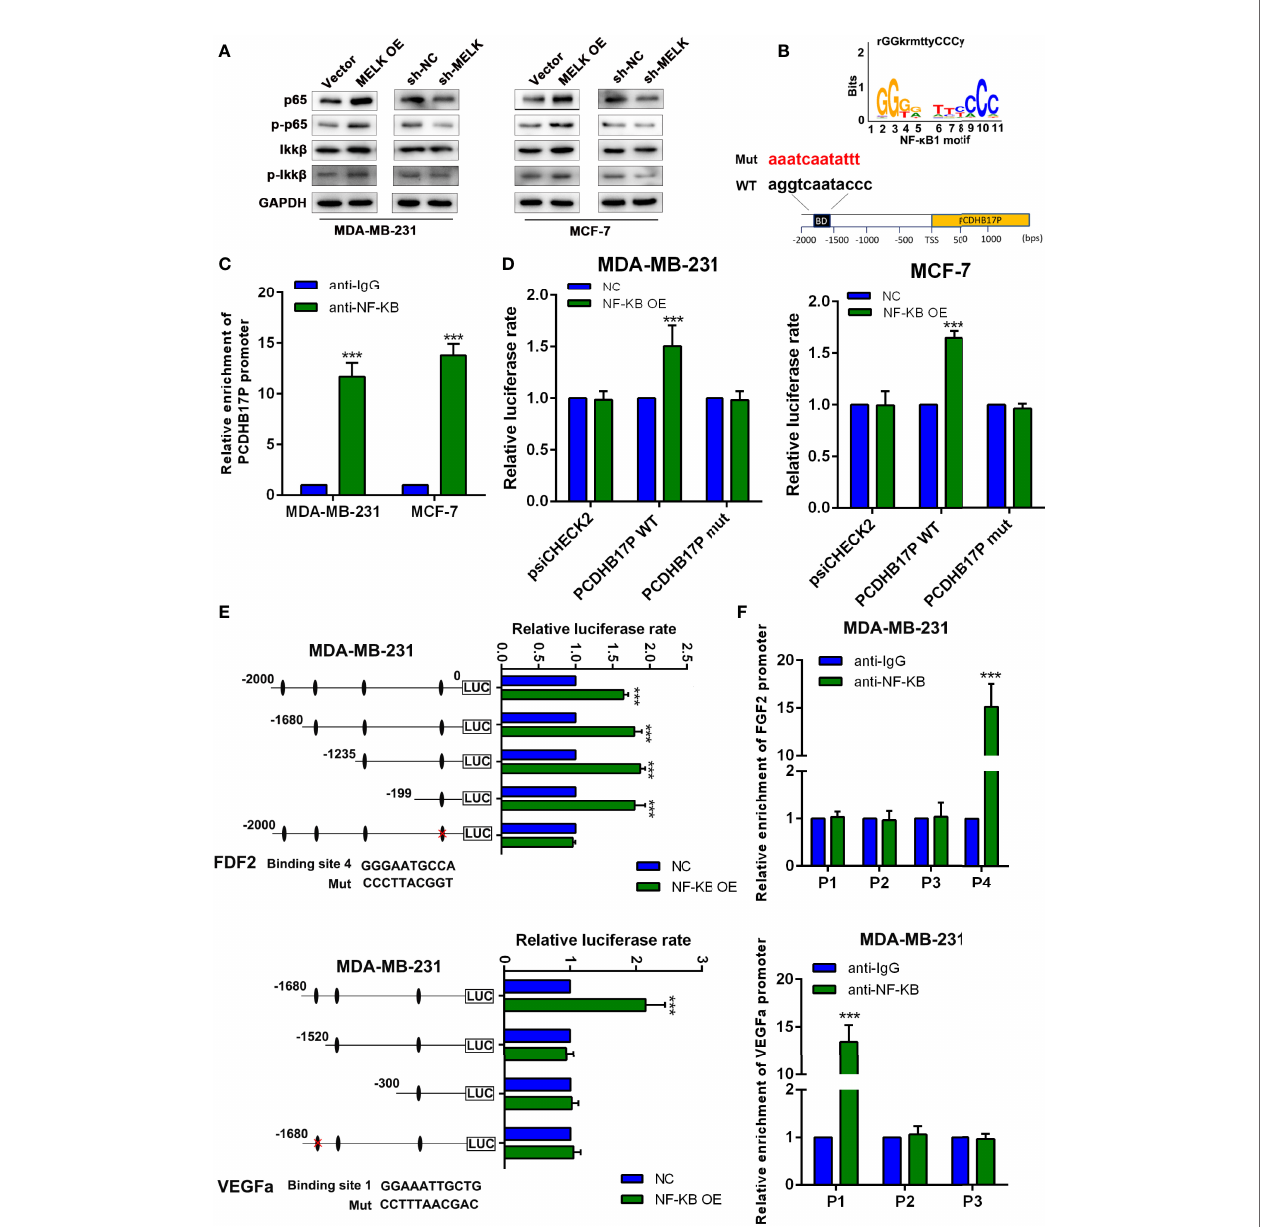
FIGURE 8 | PCDHB17P is feedback transcriptionally regulated by MELK. (A) The expression of P65, p-P65, IKK b and p-IKK b were detected in MDA-MB-231 and MCF-7 cells transfected with MELK overexpression by western blotting. (B) The binding motif of NF- k B from JASPAR tool. (C) ChIP assay demonstrating the direct binding of NF- k B to the PCDHB17P promoter in MDA-MB-231 and MCF-7 cells. (D) Luciferase reporter assay was performed in MDA-MB-231 and MCF-7 cells co-transfected NF- k B OE or pcDNA with wild-type or mutated PCDHB17P. (E) Luciferase reporter assays were used to locate the binding sequences of NF- k B to the FGF2 and VEGFA promoters in MDA-MB-231 cells. (F) ChIP assay demonstrating the direct binding of NF- k B to the FGF2 and VEGFA promoters in MDA-MB- 231 cells. The y-axis represents the relative enrichment with the anti-NF- k B antibody compared to that with the IgG control. *** P <